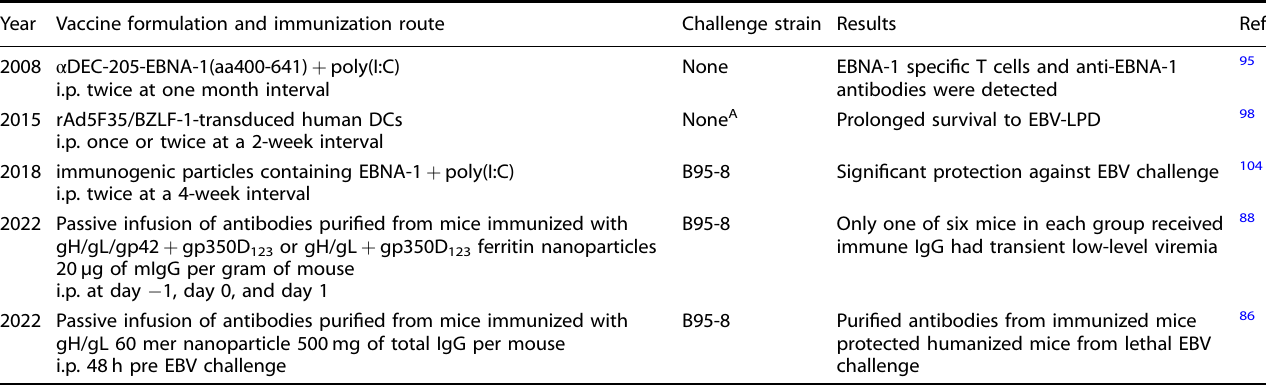
Table 2. Humanized mice models for EBV vaccines.